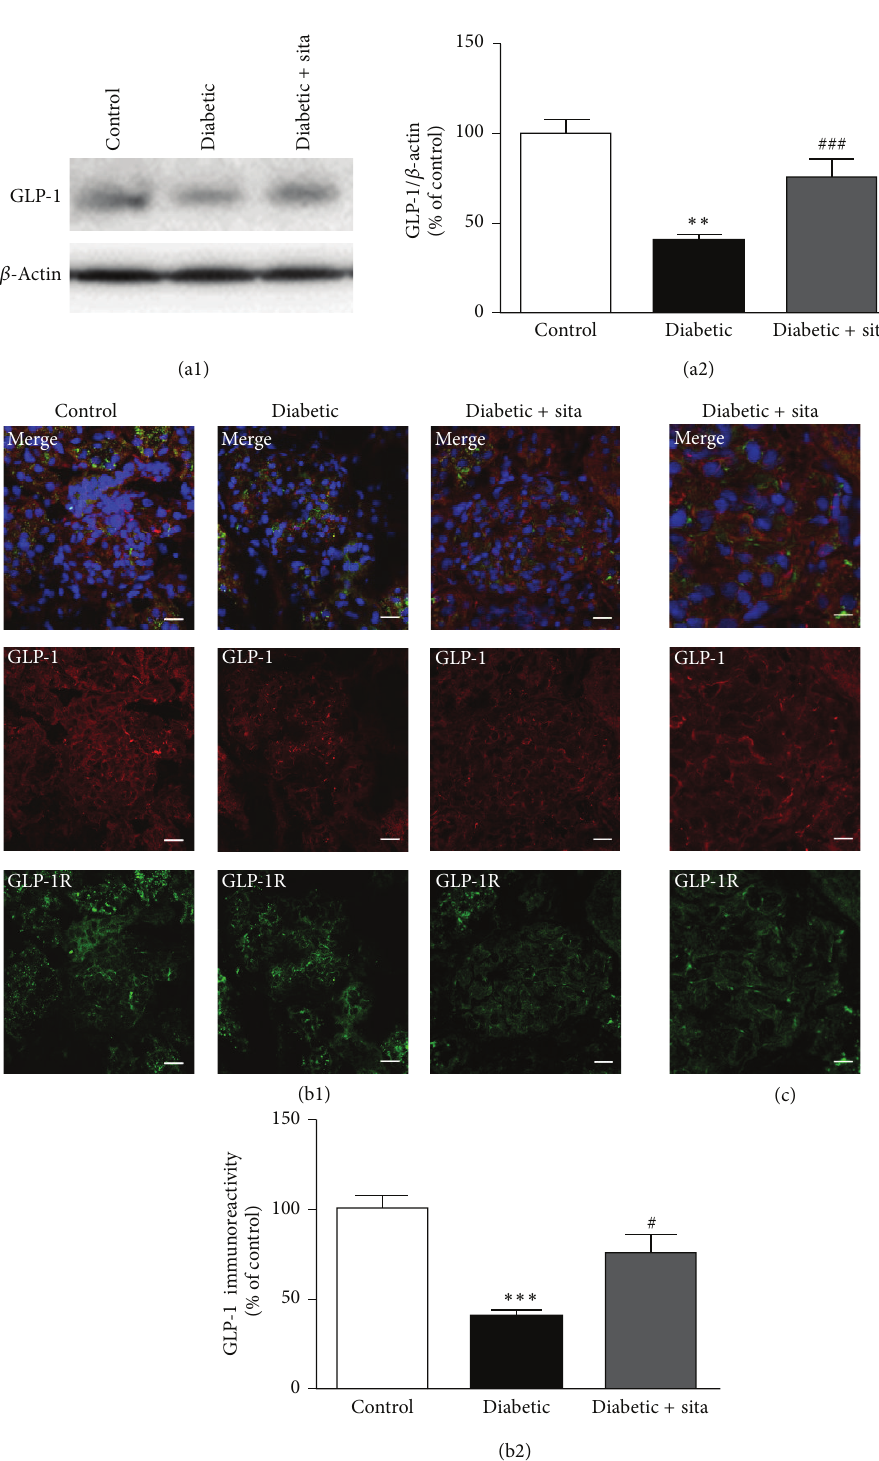
Figure 4: Sitagliptin prevents the downregulation of GLP-1 and GLP-1R content in the kidney induced by diabetes. (a) The protein levels of GLP-1 were assessed in total kidney cell lysates by Western Blotting in ZDF (+/+) and ZDF ( fa/fa ) nontreated or treated with sitagliptin. The Western Blots presented are representative of each group of animals. (b) Representative confocal images for each group of animals showing GLP-1 (red) and GLP-1R (green) immunoreactivity and nuclear staining with DAPI (blue) in kidney sections (b1), as well as immunoreactivity quantification for GLP-1 (b2). Bars = 20 𝜇 m. Data are expressed as percentage of control and represent the mean ± SEM ( 𝑛 ≥ 6 per group); ∗∗ 𝑃 < 0.01 and ∗∗∗ 𝑃 < 0.001 significantly different from control; # 𝑃 < 0.05 and ### 𝑃 < 0.001 significantly different from diabetic. (c) Magnification of representative confocal images for the group of ZDF ( fa/fa ) treated with sitagliptin showing colocalization areas of GLP-1 and GLP-1R (yellow) in kidney sections (6 𝜇 m). Bars = 10 𝜇